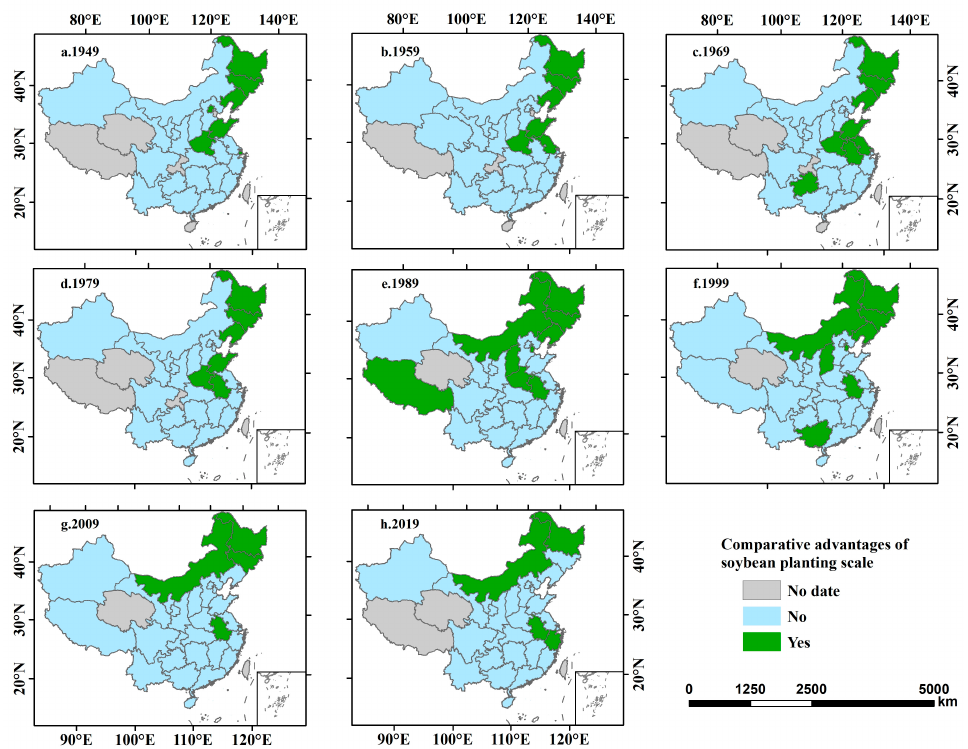
Figure 6. Spatial distribution of comparative advantages in soybean planting scales in China from 1949 to 2019.